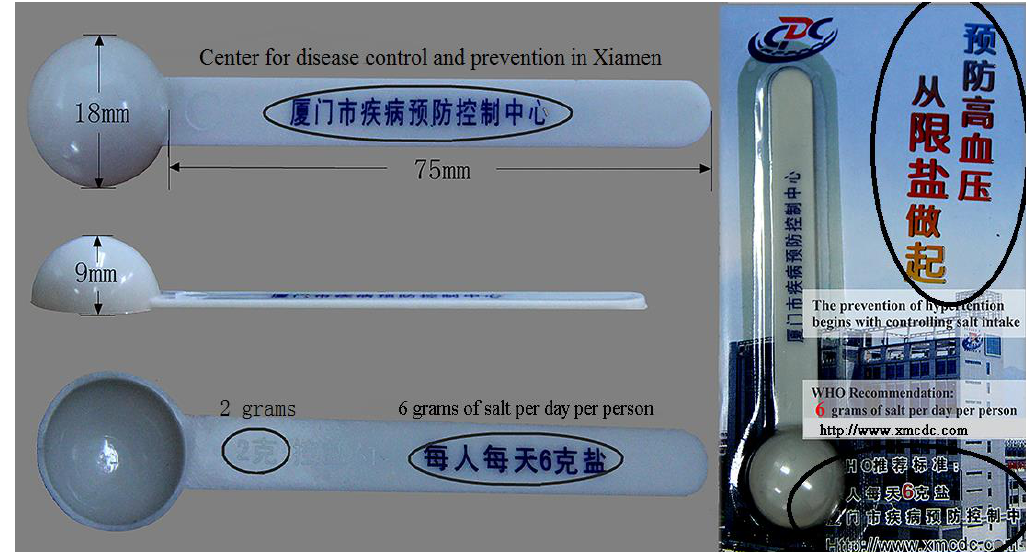
Figure 1. Teaspoon which was promoted by Center for Disease Control and Prevention (CDC) in Xiamen and used to assess the dietary salt intake. There were approximately 2 g of salt in one teaspoon, and CDC in Xiamen recommended that individuals should limit the salt intake to less than 6 g/day (three teaspoons). Chinese characters were circled and the translations were put beside them.